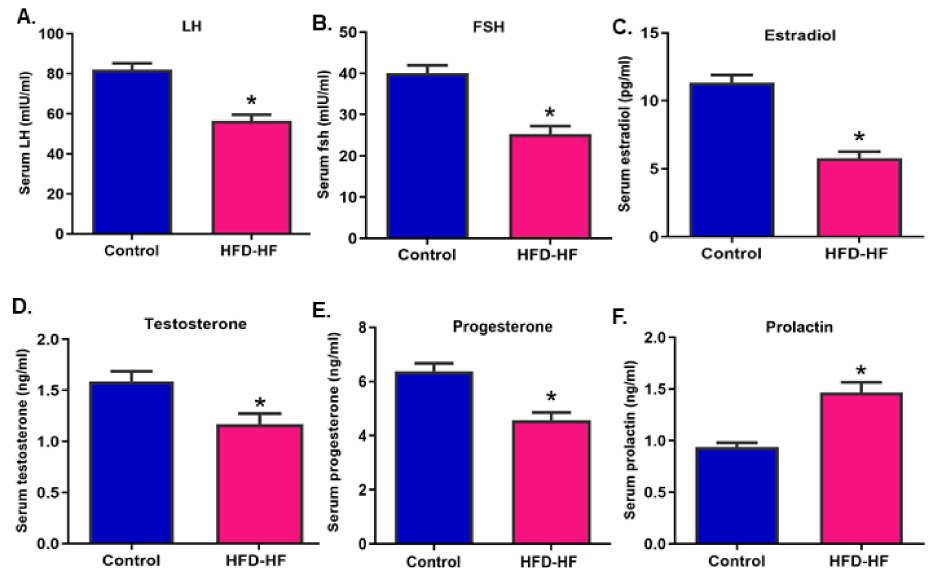
Figure 2. Serum titers of ( A ) luteinizing hormone, ( B ) follicle-stimulating hormone, ( C ) estradiol, ( D ) testosterone ( E ) progesterone, and ( F ) prolactin in adult rats subjected to an HFD-HF diet. Each value is mean ± SEM of six animals, in each group. Bars with the asterisk (*) sign denote statistically significant differences ( p ≤ 0.05 vs. control group) between the respective